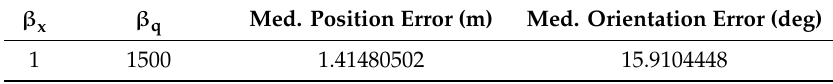
Figure 9. Error plot showing the variations under di ff erent orientation scaling coe ffi cient β q values for the weighted Euclidean-based model. Table 7. Fine-tuning errors of the weighted Euclidean-based model (30,000 iterations).